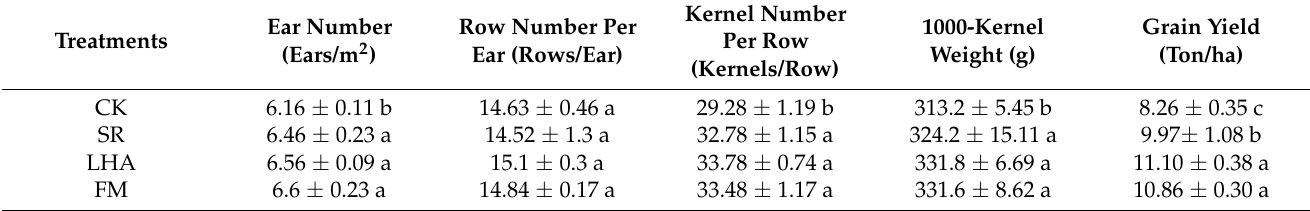
Table 4. Effects of different organic amendment materials on soil physical and chemical properties.